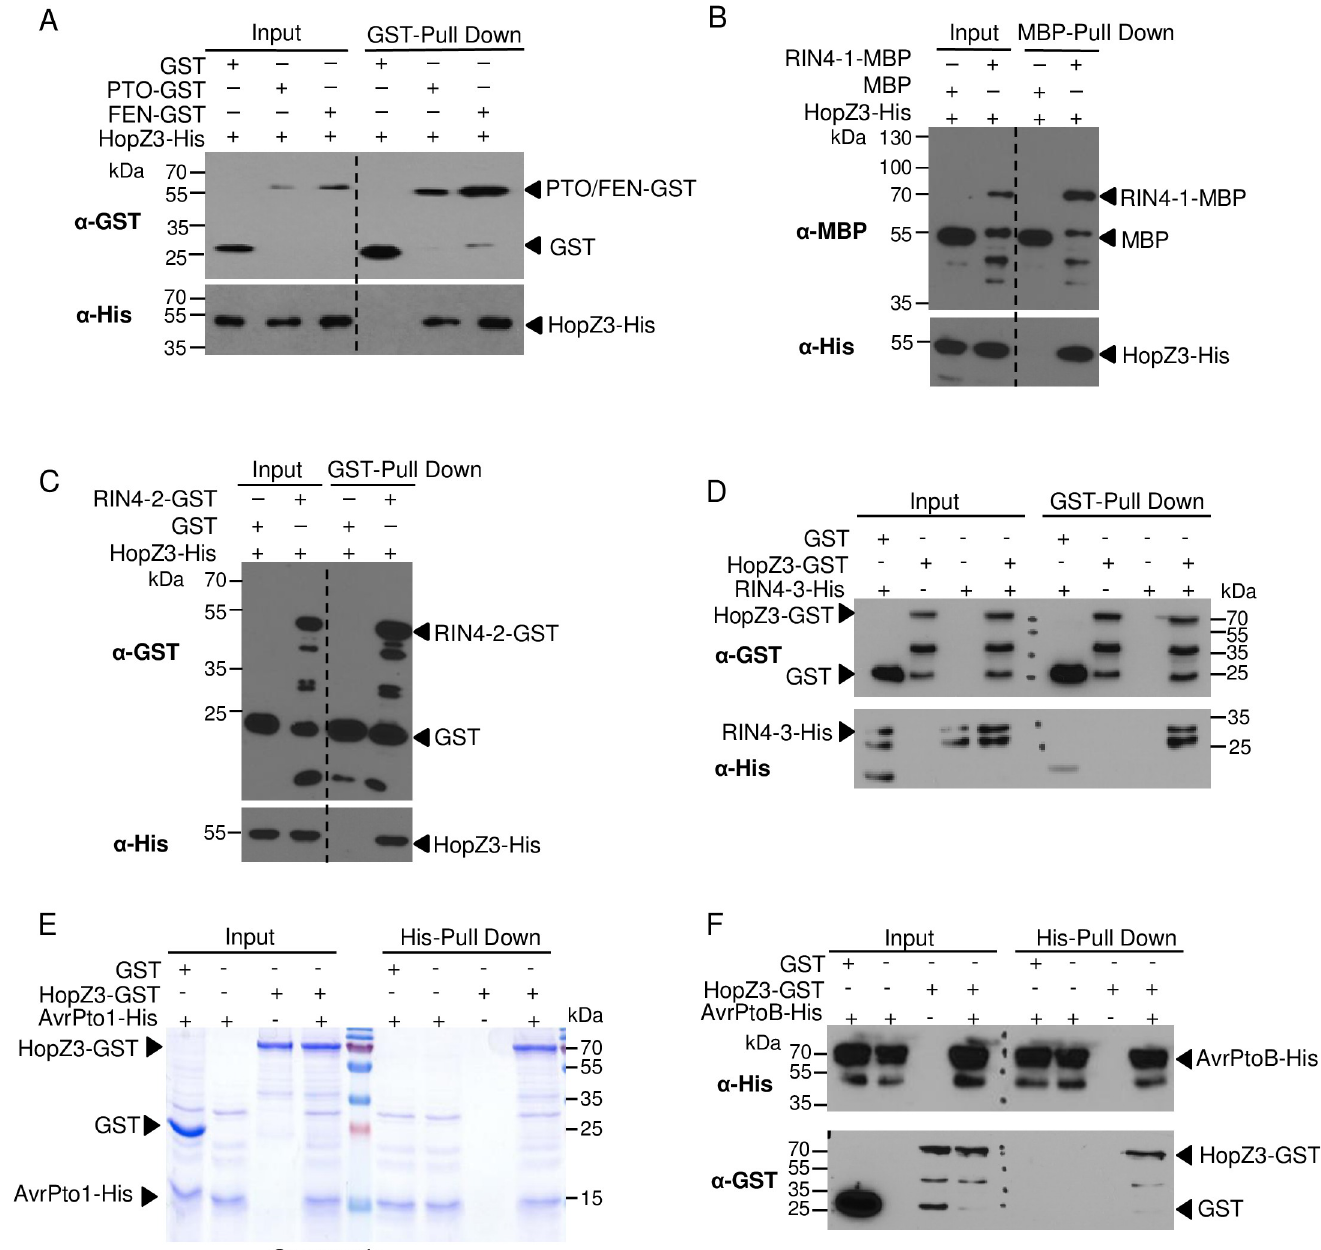
Fig 2. HopZ3 interacts with members of the PTO defense pathway and PTO activating effectors. Pull-down experiments using recombinant tagged proteins were performed to assess the interaction between HopZ3 and proteins in the PTO immune pathway. GST, MBP or beads alone were used as negative controls. Proteins were detected by immunoblotting or Coomassie staining. (A) Immobilized GST-tagged FEN and PTO were incubated with purified HopZ3-His, washed and resolved by SDS-PAGE. Immunoblotting showed interactions between these proteins and HopZ3. (B-D) HopZ3 interacts with all three tomato RIN4s. Immobilized MBP-tagged SlRIN4-1 (B) or GST-tagged SlRIN4-2 (C) pulled down HopZ3-His and immobilized HopZ3-GST pulled down SlRIN4-3-His (D). (E) GST-tagged HopZ3 was pulled down using immobilized AvrPto1 -His, showing their interaction. (F) HopZ3-GST was pulled down by immobilized AvrPtoB -His. Dashed Psy Psy lines in (A-C) separate input from pull down in the same blot and in (D, F) they mark protein weight